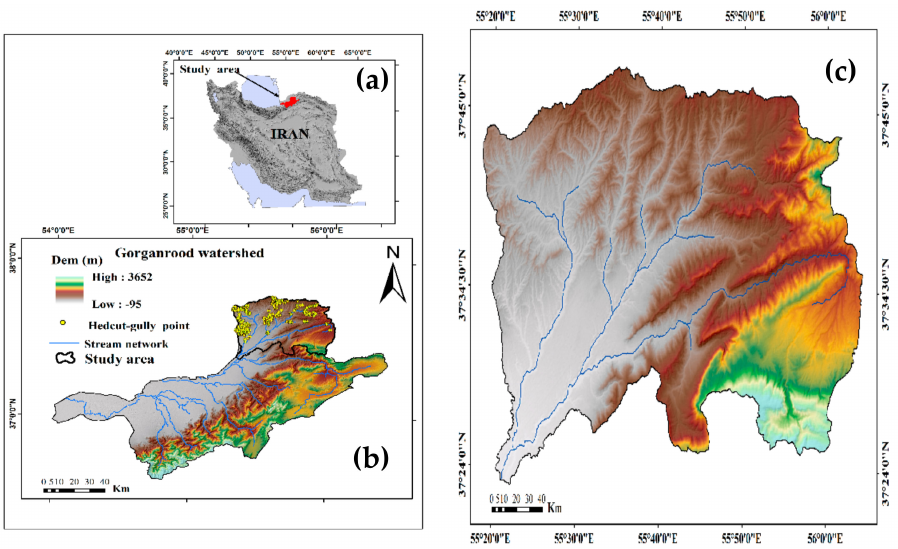
Figure 1. Study area and topographical characteristics. ( a ) Iran, ( b ) Gorganrood Watershed, ( c ) Study